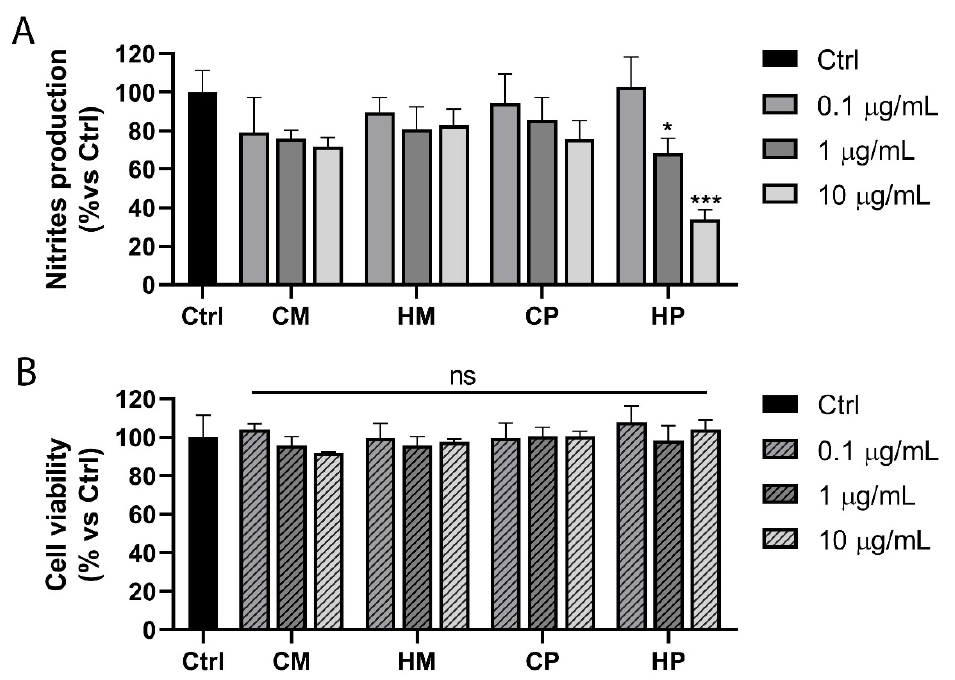
Figure 6. Anti-inflammatory potential of the extracts. ( A ) Nitrites production assessment, by Griess assay, in lipopolysaccharide (LPS)-stimulated RAW 264.7 cells treated with increasing doses (0.1 to 10 μg/mL) of different extract (as indicated) or DMSO (Ctrl). Data are expressed as percentage of nitrite production versus control (DMSO-treated cells). ( B ) Viability assessment, by MTT assay, of cells treated as indicated above. Values represent mean ± SD of three independent experiments. * p < 0.05; *** p < 0.001; ns = not significant.